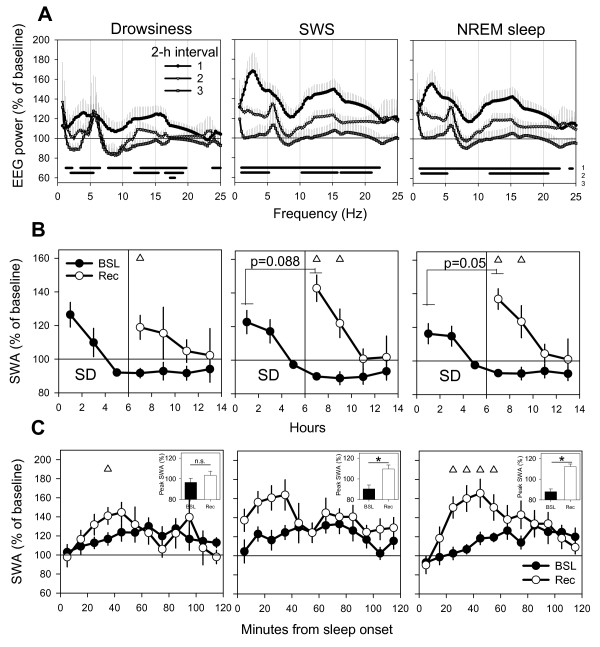
EEG power spectrum and SWA during recovery sleep. A. Time course of EEG power spectrum in drowsiness, SWS and the two states combined for the first three 2-hour intervals of recovery sleep. For each frequency bin (0.25 Hz) curves connect means (± SEM, n = 6) of relative power density expressed as percentage of mean values in that bin over the baseline dark period in the corresponding vigilance state. Horizontal bars depict frequency bins where the EEG power during recovery was significantly different from that during the corresponding baseline interval (p < 0.05, paired t-test). B. Time course of SWA (0.5–4 Hz) in drowsiness, SWS sleep and the two states combined. For each vigilance state, the 2-hour values are expressed as percentage of mean SWA during the baseline dark period in the corresponding vigilance state. Triangles depict significant difference between SWA during recovery sleep relative to the same circadian time during baseline sleep. Note that SWA in SWS and in NREM sleep (SWS + drowsiness) at the beginning of recovery sleep shows a trend to be higher (SWS, p = 0.08; NREM sleep, p = 0.05, paired t-test) than at the beginning of baseline sleep. C. Time course of SWA (0.5–4 Hz) in drowsiness, SWS sleep and the two states combined during the first 2 hours after sleep onset in baseline sleep and recovery sleep. For each vigilance state, values are expressed as percent of mean SWA during baseline for the corresponding vigilance state. Each data point represents mean (± SEM, n = 6) SWA over consecutive 10-min intervals. Triangles depict significant differences between SWA during recovery sleep relative to baseline sleep (p < 0.05, paired t-test). Inset depicts mean values (± SEM, n = 6) of peak SWA during the first 2 hours of baseline and recovery sleep analyzed over 30-min intervals. Asterisks indicate significant difference between baseline and recovery sleep (p < 0.05, paired t-test).